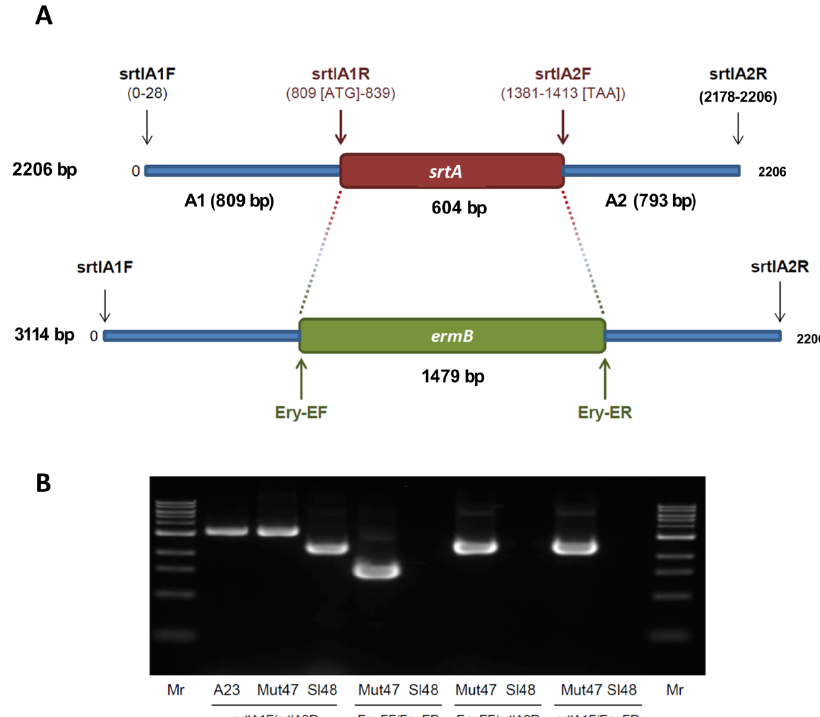
Figure 2. Genetic map of srtA and primer positions for PCRs, and results of PCR confirming the gene depletion of srtA in S. lugdunensis . ( A ) The gene loci of srtA in S. lugdunensis are shown before and after the recombination processes. In addition, the gene loci of srtA in S. lugdunensis are shown before and after the recombination processes and the positions of primer binding during the PCR experiments. The primer sequences are given in Table 3. ( B ) PCR products from genomic DNA of S. lugdunensis wild-type strain (Sl48), ∆ srtA mutant strain (Mut47) and plasmid DNA of pBT srtA (A23) were separated by 1% agarose gels. Higher molecular bands (PCR with primer pair srtlA1F and srtlA2R) and the occurrence of corresponding bands to PCR experiments with primer pairs Ery-EF / Ery-ER, Ery-EF / srtlA2R and srtlA1F / Ery-ER confirming the deletion of srtA and following substitution by the ermB gene in the genome S. lugdunensis ∆ srtA mutant strain